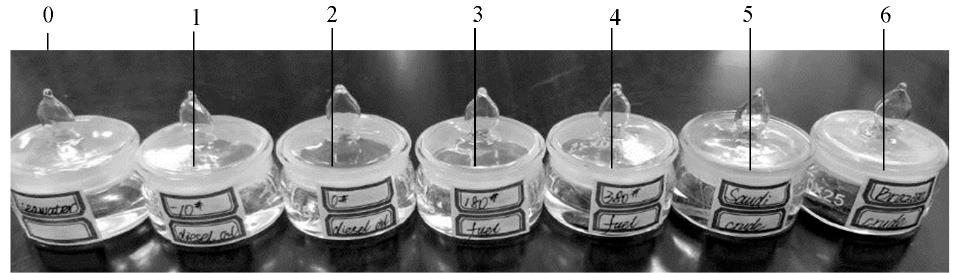
Figure 3. Laboratory samples used to simulate oil spills on seawater.